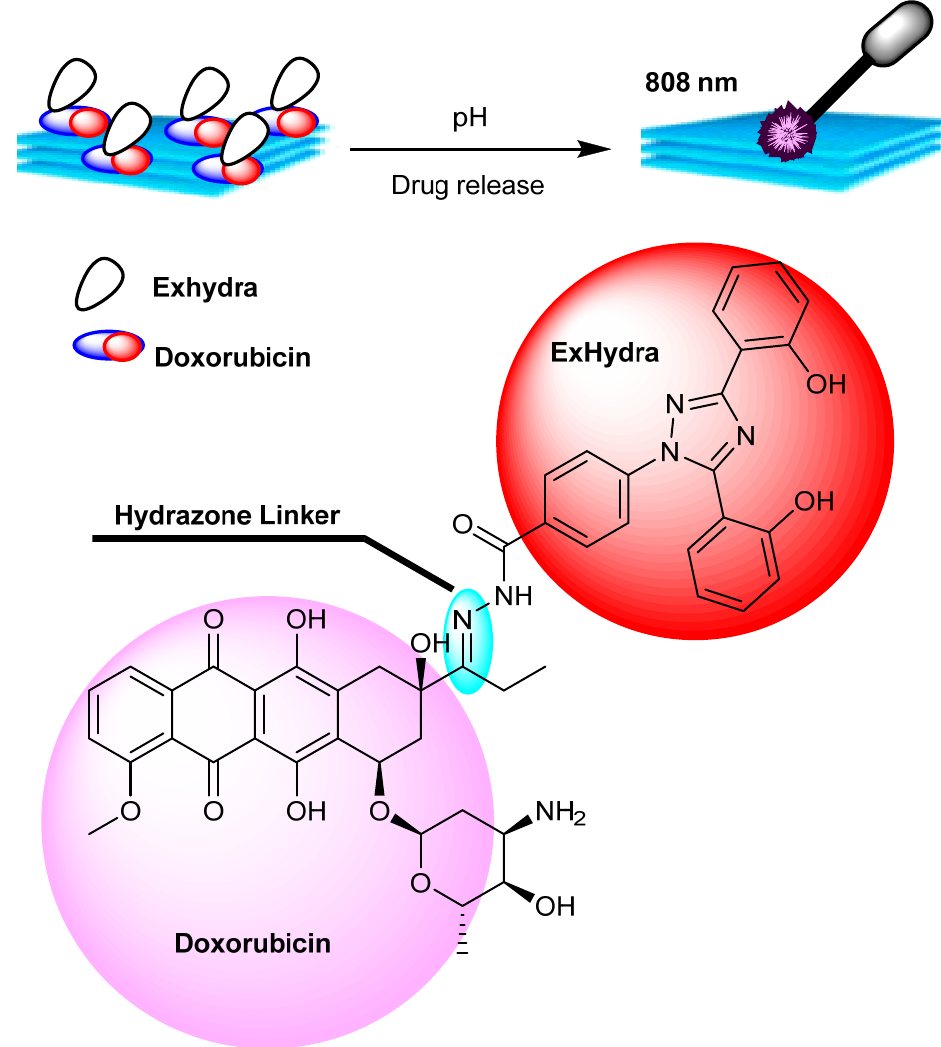
Figure 3. Synthesis of 2D-ultrathin MXene/DOXjade platforms for targeted cancer therapy [95].